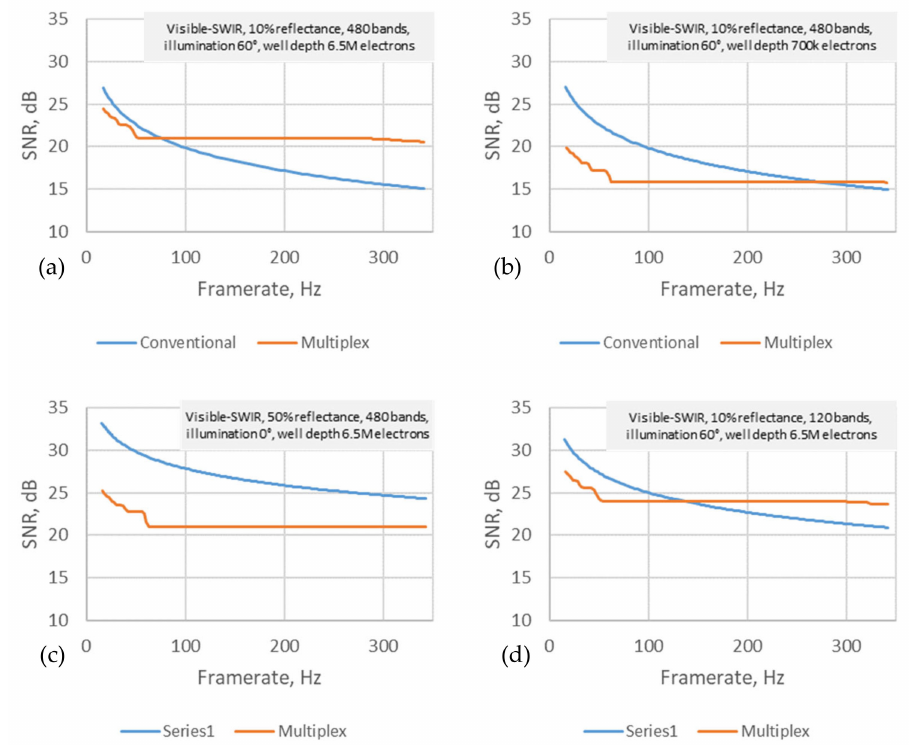
Figure 7. Depicts the variation of the SNR as a function of frame rate for conventional spectrograph and CA multiplexed sensors under a range of sensing parameters: ( a ) ground albedo 10% and 60 ◦ illumination angle, ( b ) well depth reduced to 700 K electrons, ( c ). illumination at 0 ◦ from zenith, ( d ) 120 bands.